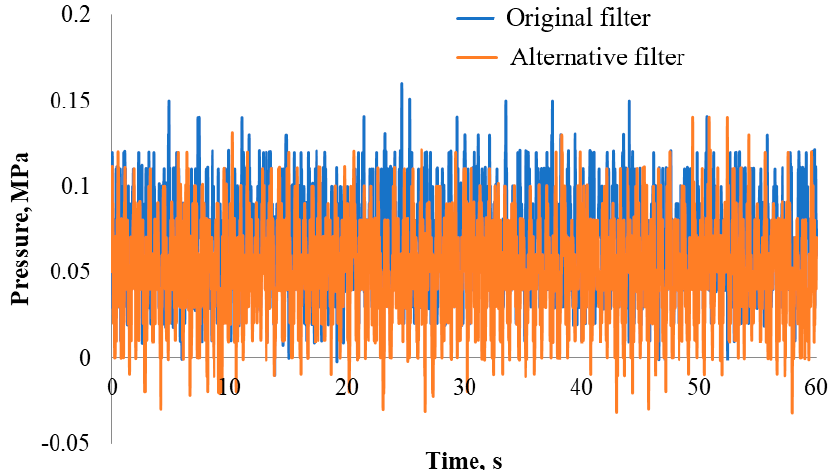
Figure 12. The plot of measuring the pressure of contaminated oil using the tested oil filters at an operating oil temperature of 30 °C in test circuit B.